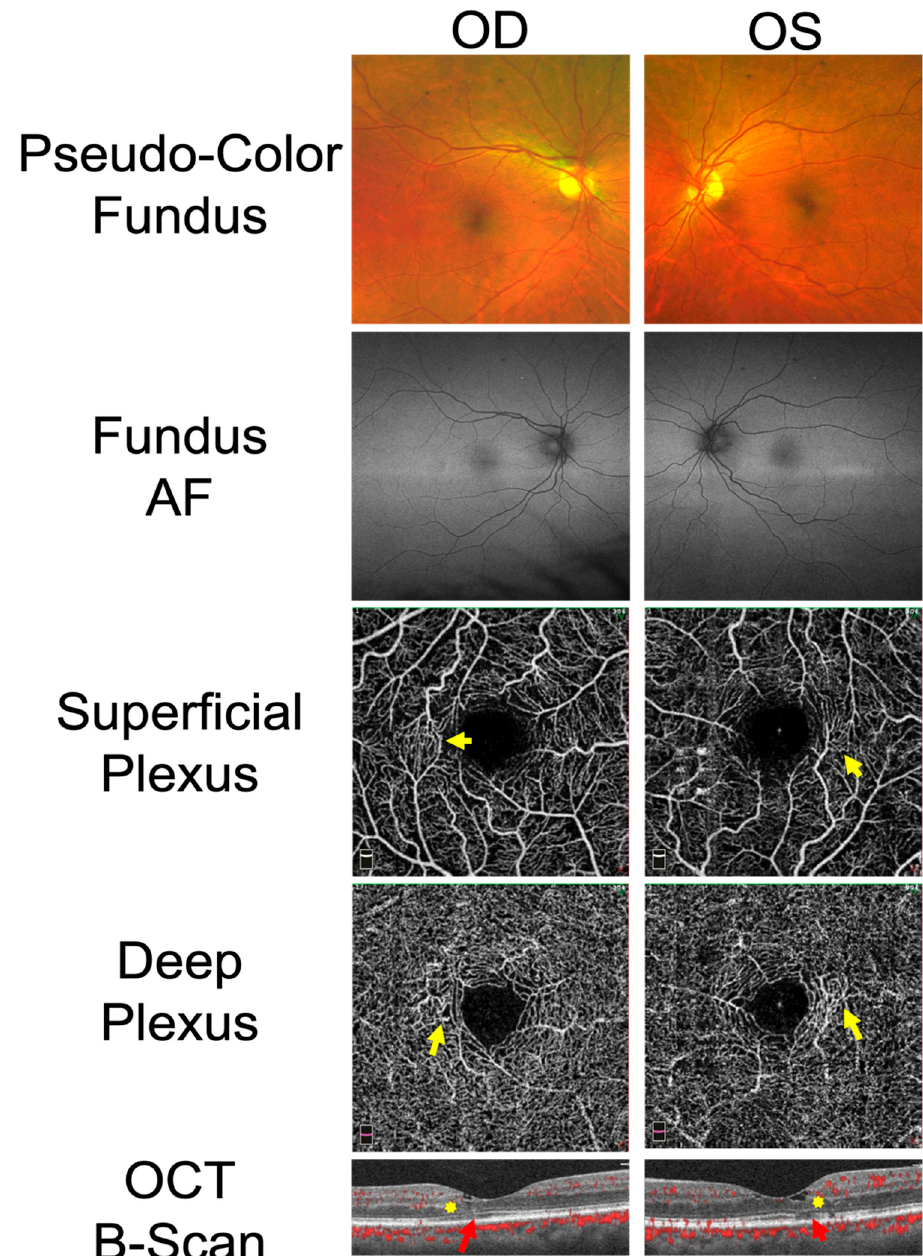
Figure 2. Multimodal imaging findings in patient H, who presented for a diabetic eye evaluation concerning diabetic macular edema (DME). Right and left eyes are shown. Pseudo-color fundus and fundus autofluorescence (AF) imaging are unremarkable. In both eyes, imaging of the superficial and deep capillary plexuses reveals telangiectatic vessels, primarily concentrated temporally in the superficial plexus, but becoming circumferential in the deep plexus (yellow arrows). OCT B-Scan shows minor cystic changes occurring in the inner retina and focally limited to the temporal fovea (yellow stars). Ellipsoid zone (EZ) loss is also present predominantly temporally to the fovea (red arrows).